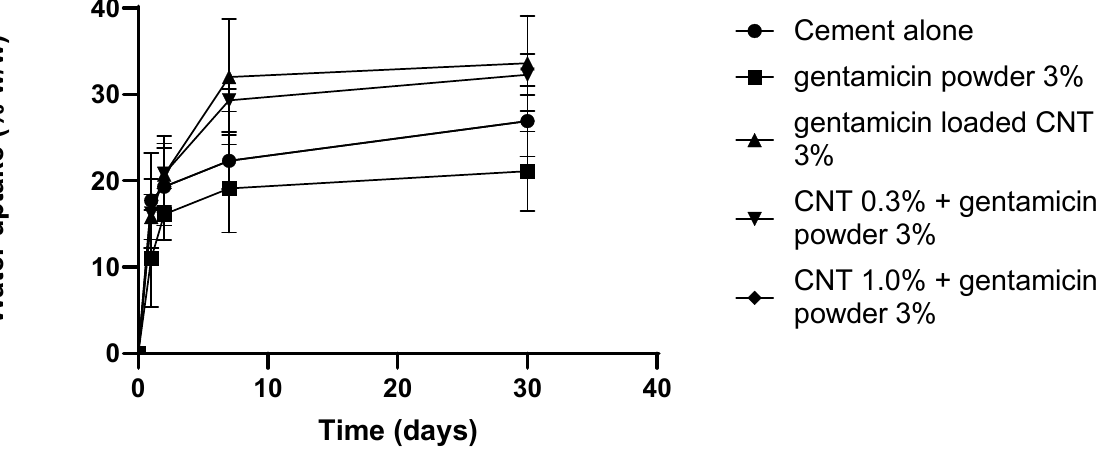
Figure 7. Water uptake for different bone cements after incubation in pH 7.4 PBS buffer ( n = 3 ± SD).